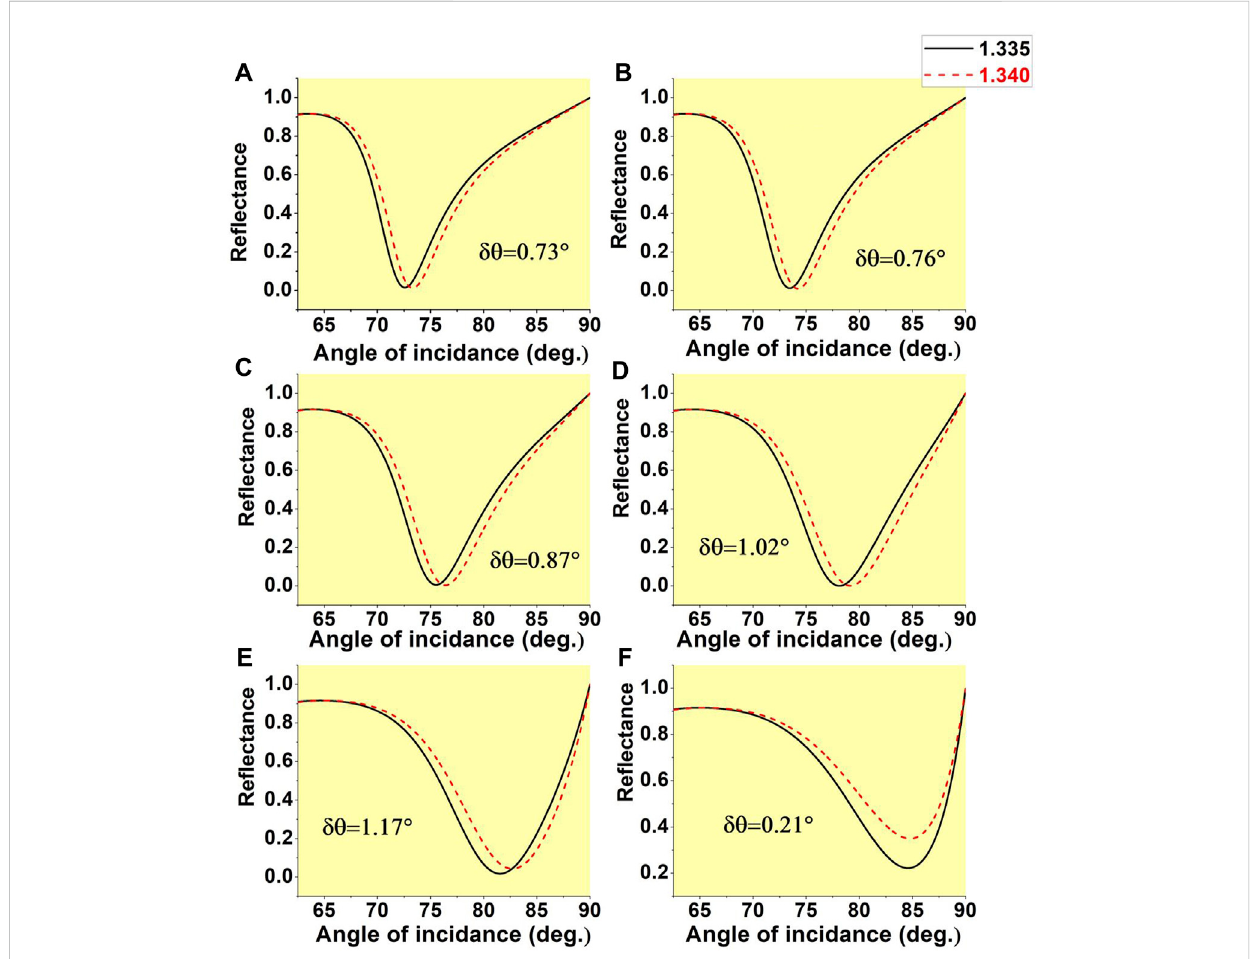
FIGURE 6 The variation of the re fl ectance with the angle of the incidence of the prism for the two RI of the analyte 1.335 and 1.340 when the thickness of the adhesion layer of MgO is considered as 15 nm, while the number of BP layers on Ag are (A) 1 layer (B) 2 layers (C) 4 layers (D) 6 layers (E) 8 layers (F) 10 layers.